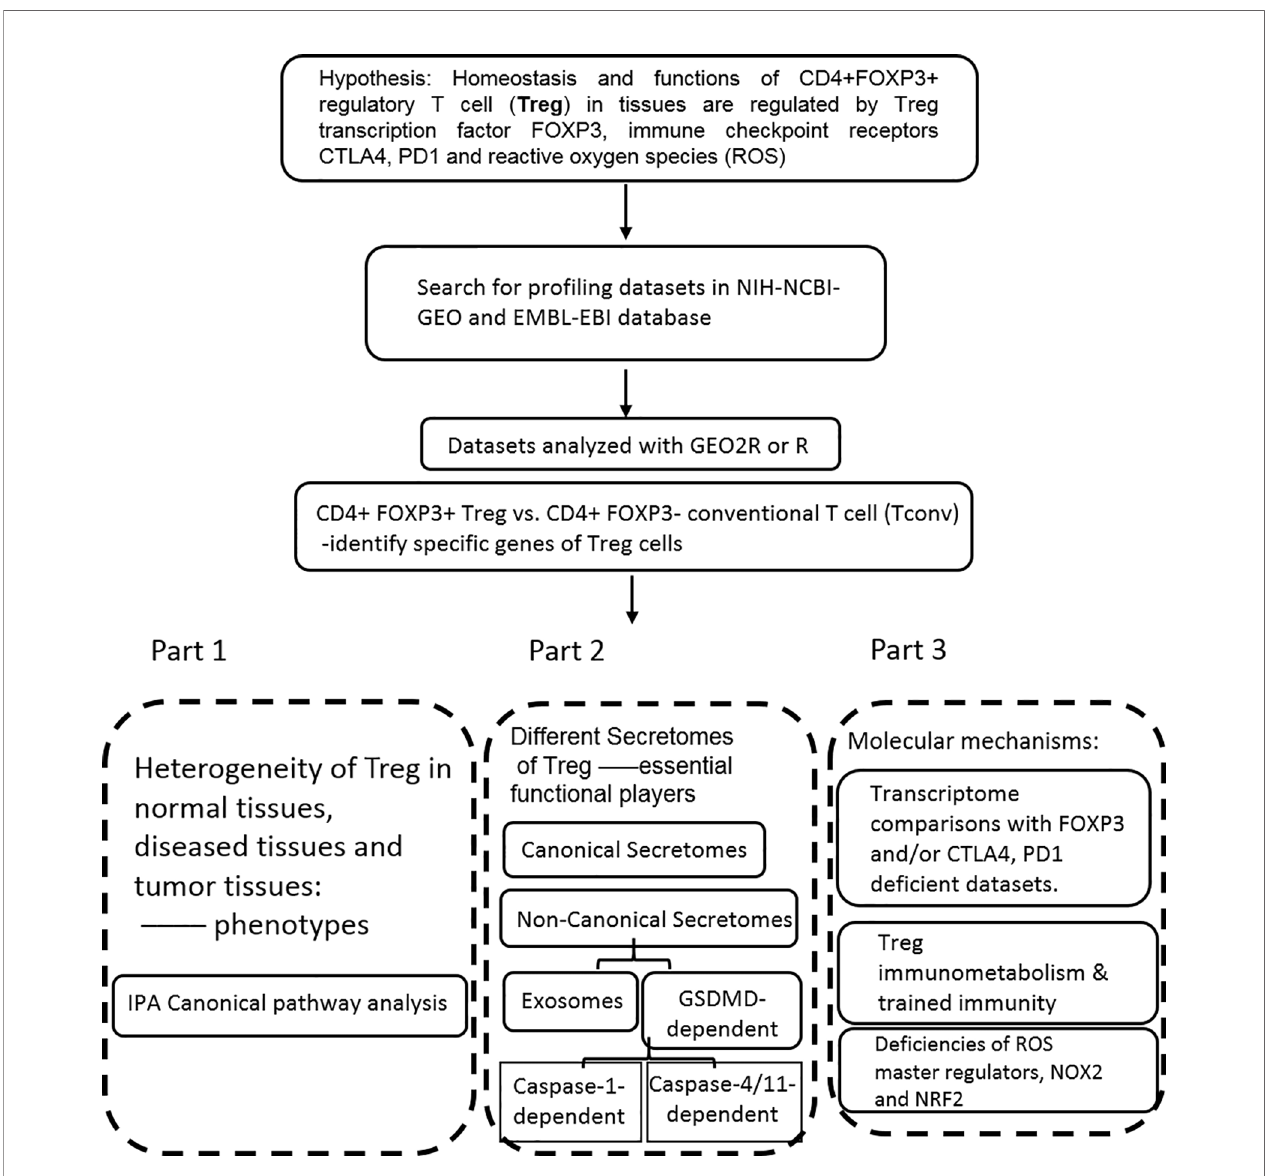
FIGURE 1 | The fl ow chart of CD4+Foxp3+ regulatory T cell (Treg) transcriptomic and secretomic analyses from normal tissues, diseased tissues and tumor tissues. Two most comprehensive gene expression databases were used in this study: NIH-NIBI-GEO: National Institutes of Health (NIH)-National Center for